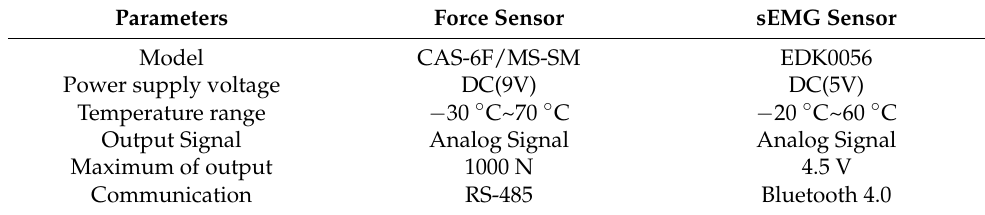
Figure 8. ( A ) System layout in the experiment. The elbow flexion was performed under isometric contraction, and the interaction force was measured by six-axis force sensor. sEMG sensor electrodes were placed on the muscle belly of the biceps brachii, brachialis and brachioradialis to collect the sEMG signal. ( B ) The prototype of our six-axis force sensor. ( C ) The internal structure of our six-axis force sensor. Table 2. Parameters of force sensor and sEMG